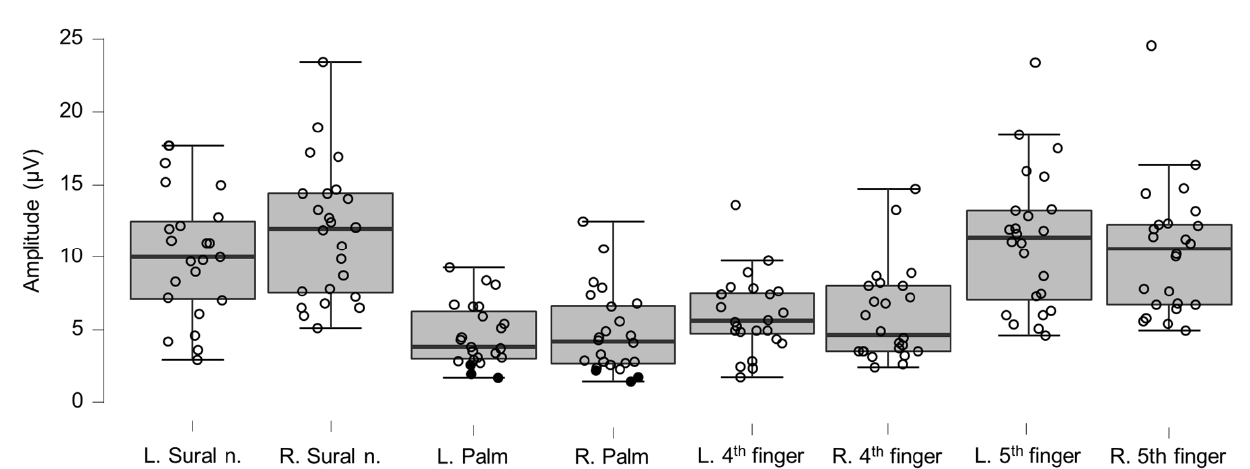
Figure 10. Box-plots for sensory neurography amplitudes. Lower and upper box boundaries represent the 25th and 75th percentiles, respectively. The line inside the box represents the median and the lower and upper whiskers represent the 10th and 90th percentiles. Filled circles represent values ≥ two standard deviations outside reference values. Table 9. Sensory neurography conduction velocities for left and right sural and ulnar nerves. ** and *** indicate statistically significant differences to reference material with p -values corresponding to Bonferroni corrected 0.01, and 0.001, respectively.